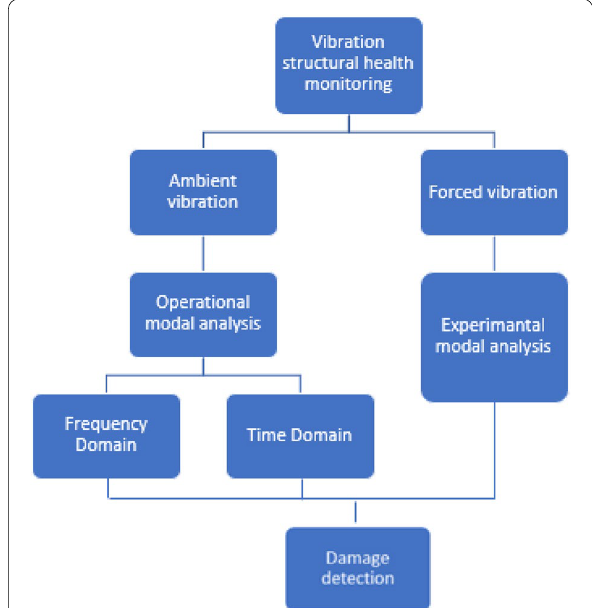
Fig. 9 Summarisation of vibration-based structural health monitoring